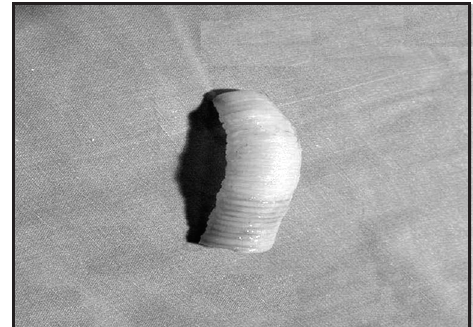
Figure 2. Photograph of a glyc- erin-preserved trachea segment after hydration. Its stiffness and macroscopic structure were closely similar to those of fresh trachea. (tracheal segment with 9 cm in